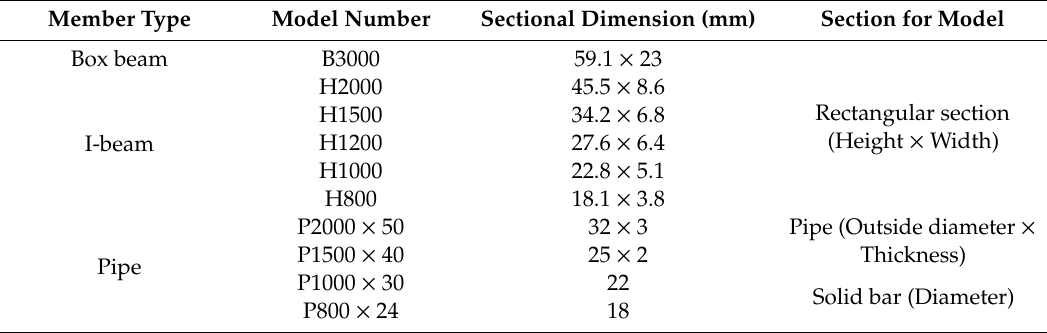
Table 2. Geometric dimension parameters of the superstructure model.